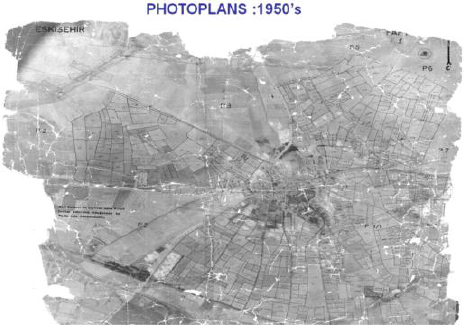
Figure 2. Photo plan sample from